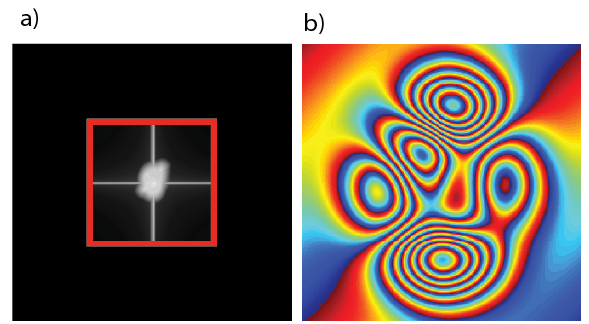
Fig. 2. A) Filtered Fourier domain with denoted part corresponding to Fig. 1c and b) wrapped phase obtained as an angle of the complex field computed by inverse Fourier transform of spectrum shown in